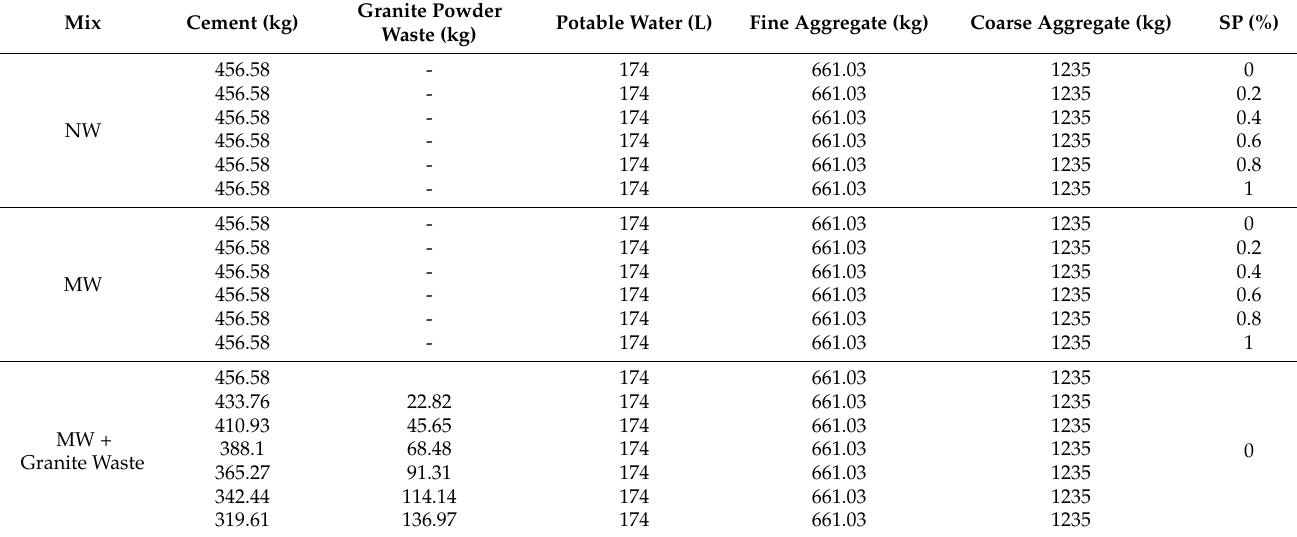
Table 5. Mix proportions of concrete samples for 1 m 3 .